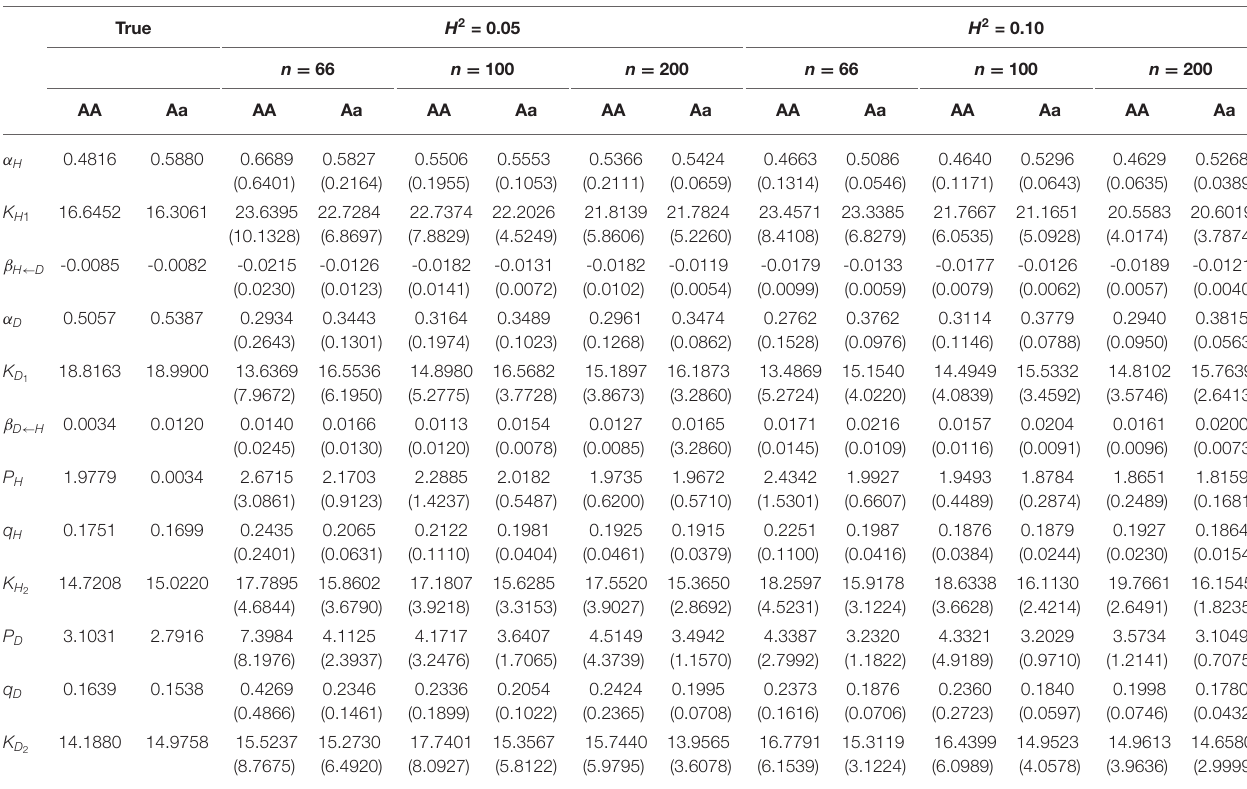
TABLE 3 | Parameter estimation of